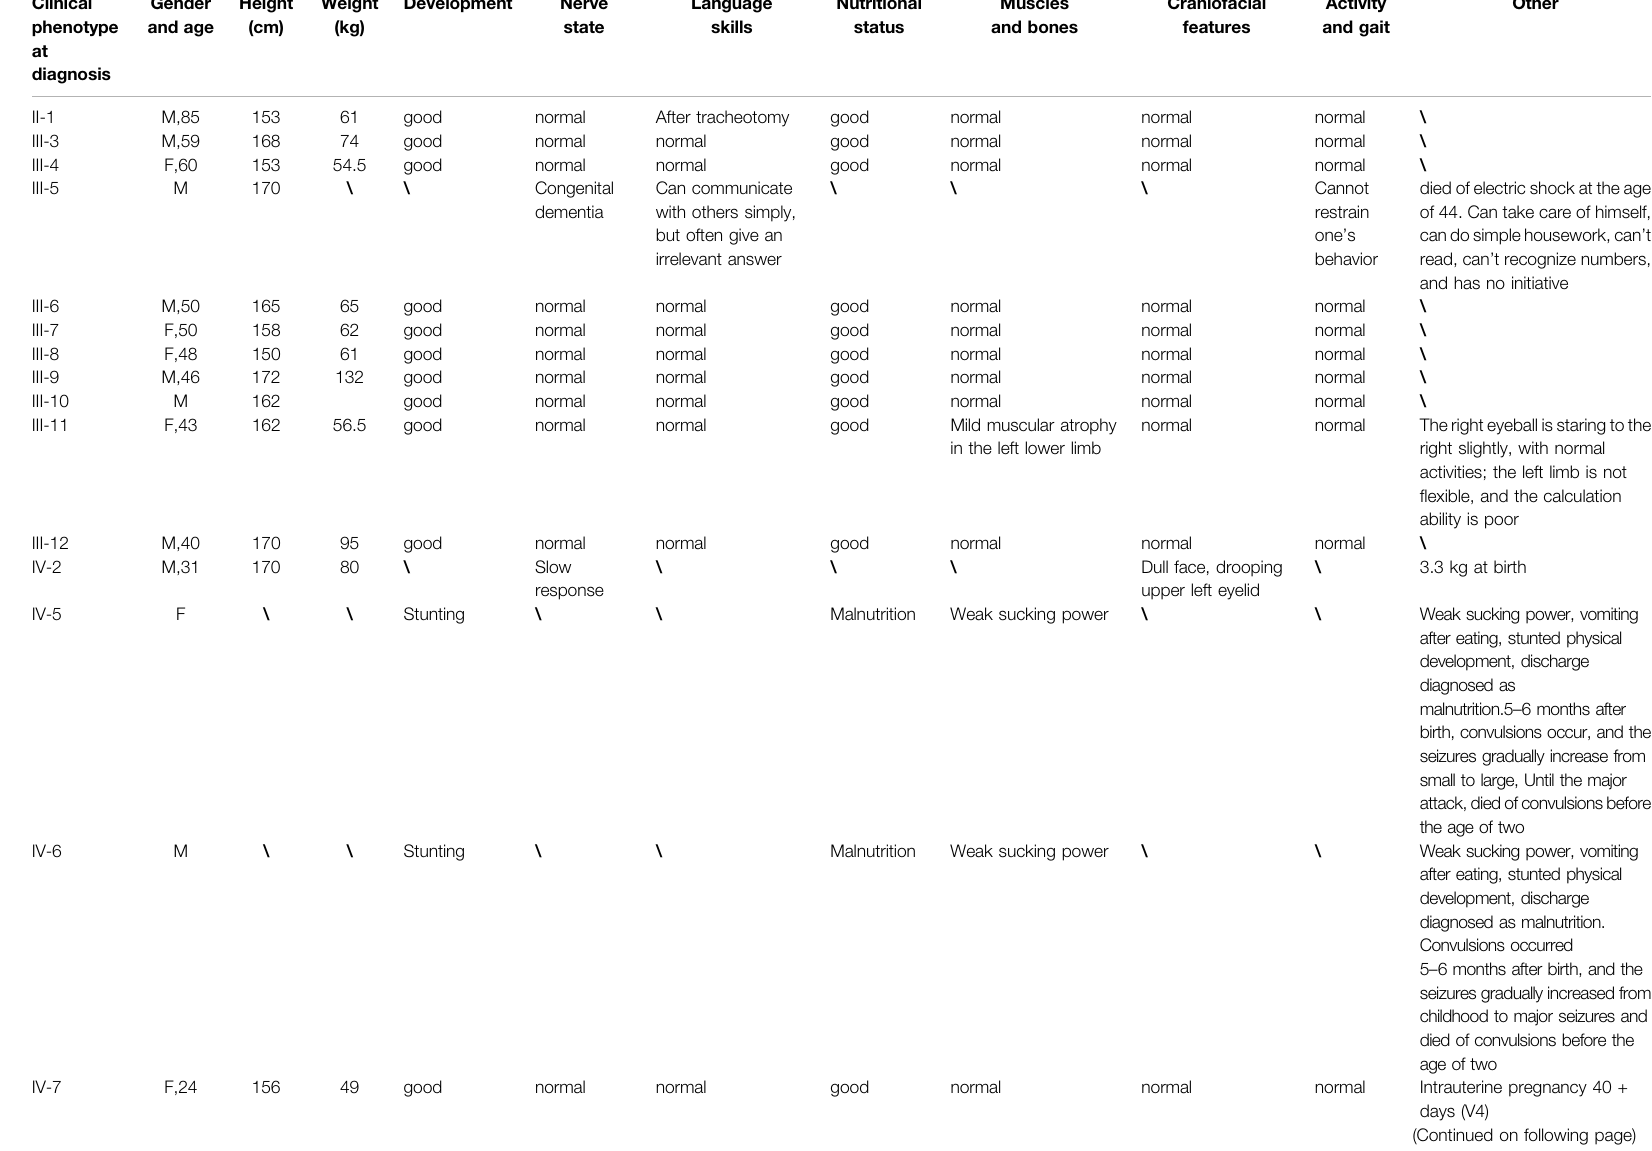
TABLE 1 | Details of the family